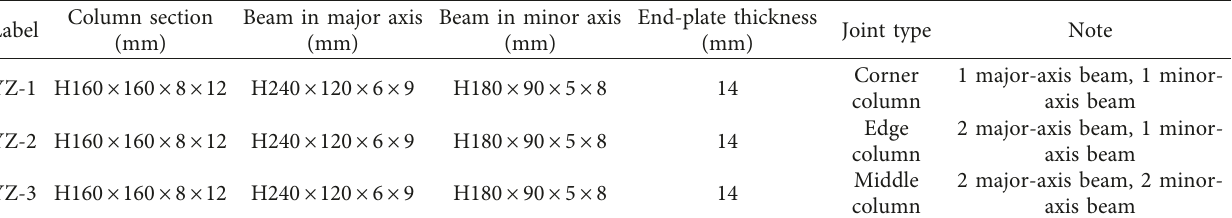
Table 6: Sizes of the spatial